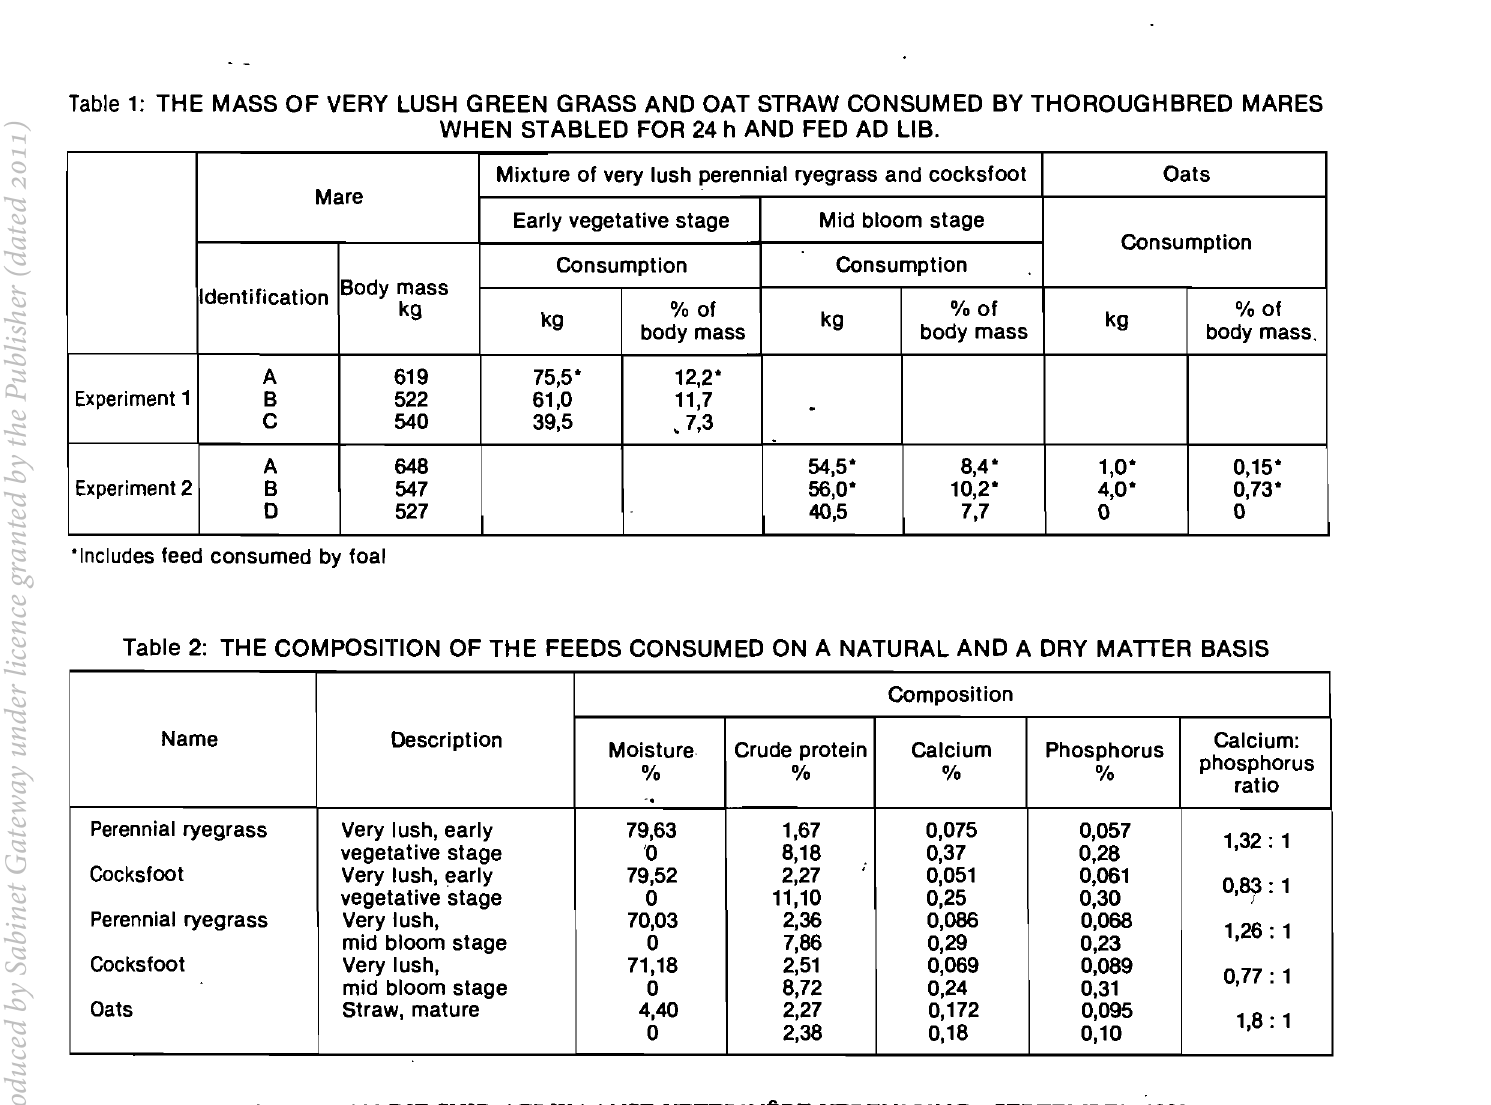
Table 2' THE COMPOSITION OF THE FEEDS CONSUMED ON A NATURAL AND A DRY MATTER